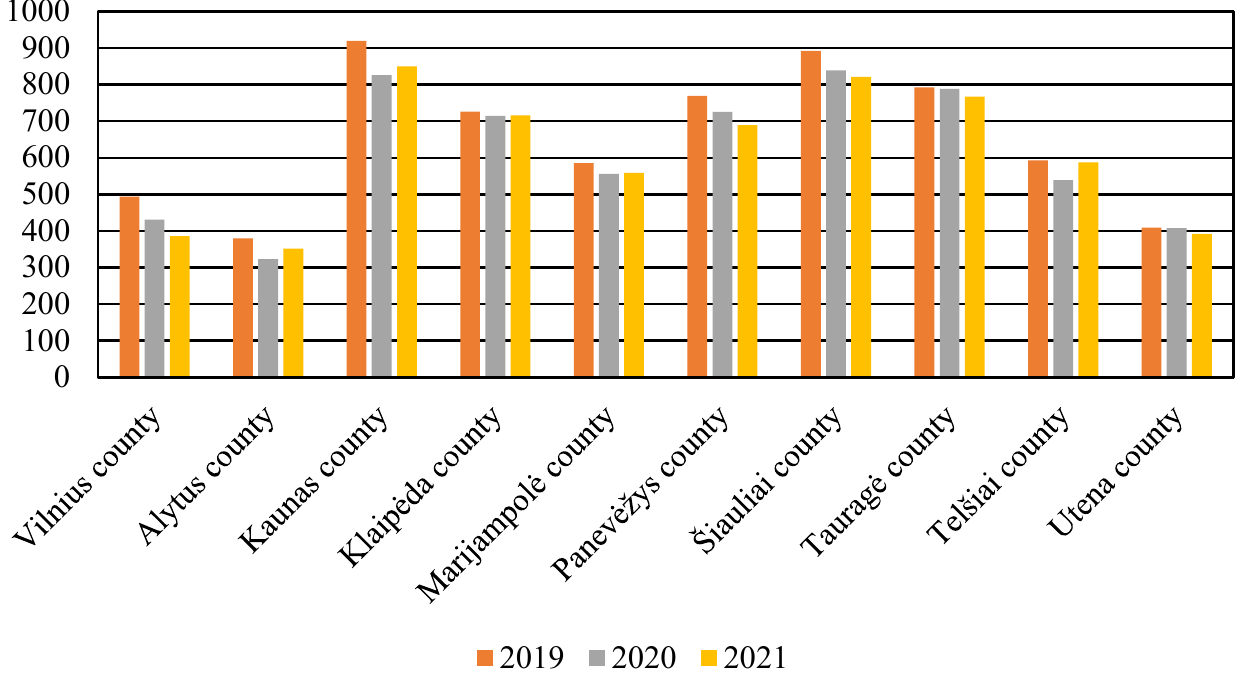
Figure 9. The potential of livestock by-products for production of gas-like types of fuel in the counties (thous. m 3 ).